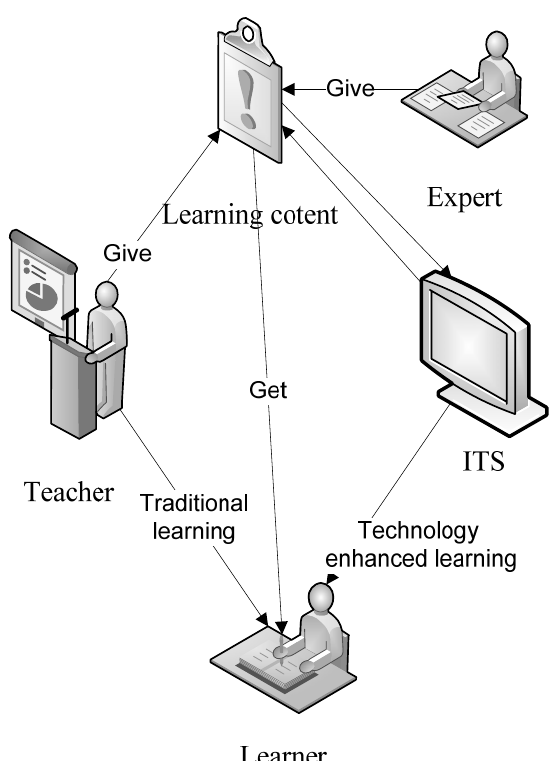
Fig. 2. Learning comparison